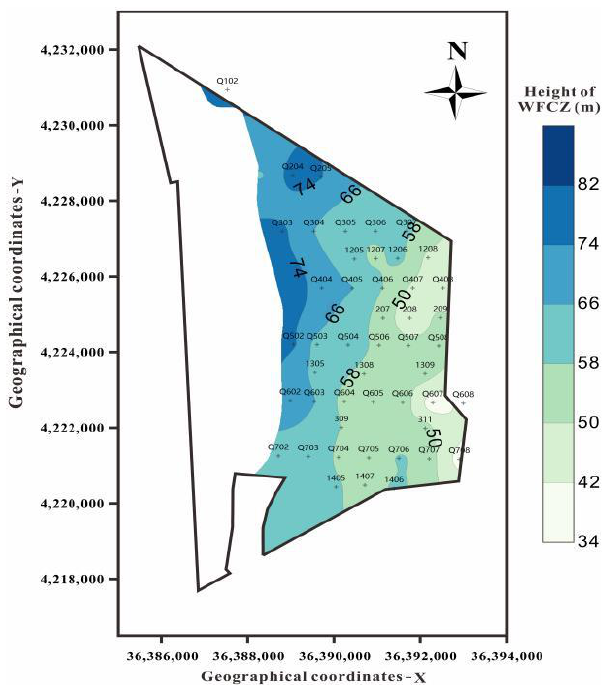
Figure 4. Contour map of height prediction of WFCZ.